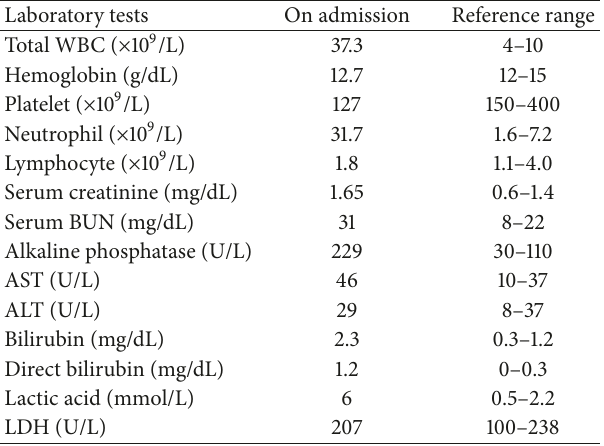
Table 1: Laboratory parameters on